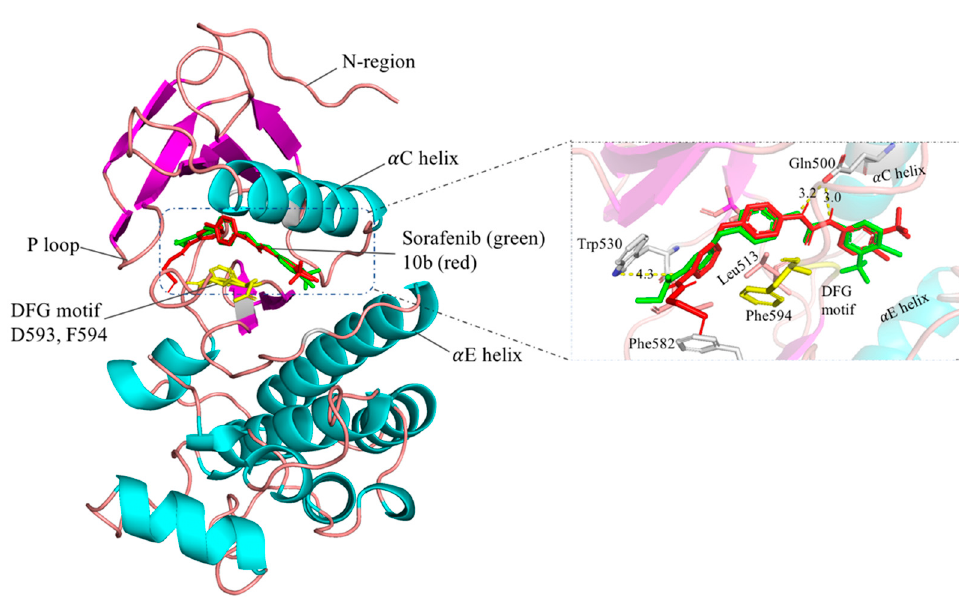
Figure 3. Predicted binding mode of sorafenib and compound 10b (affinity: − 11.2 kcal/mol) in B-RAF kinase. Sorafenib is in green and compound 10b in red.